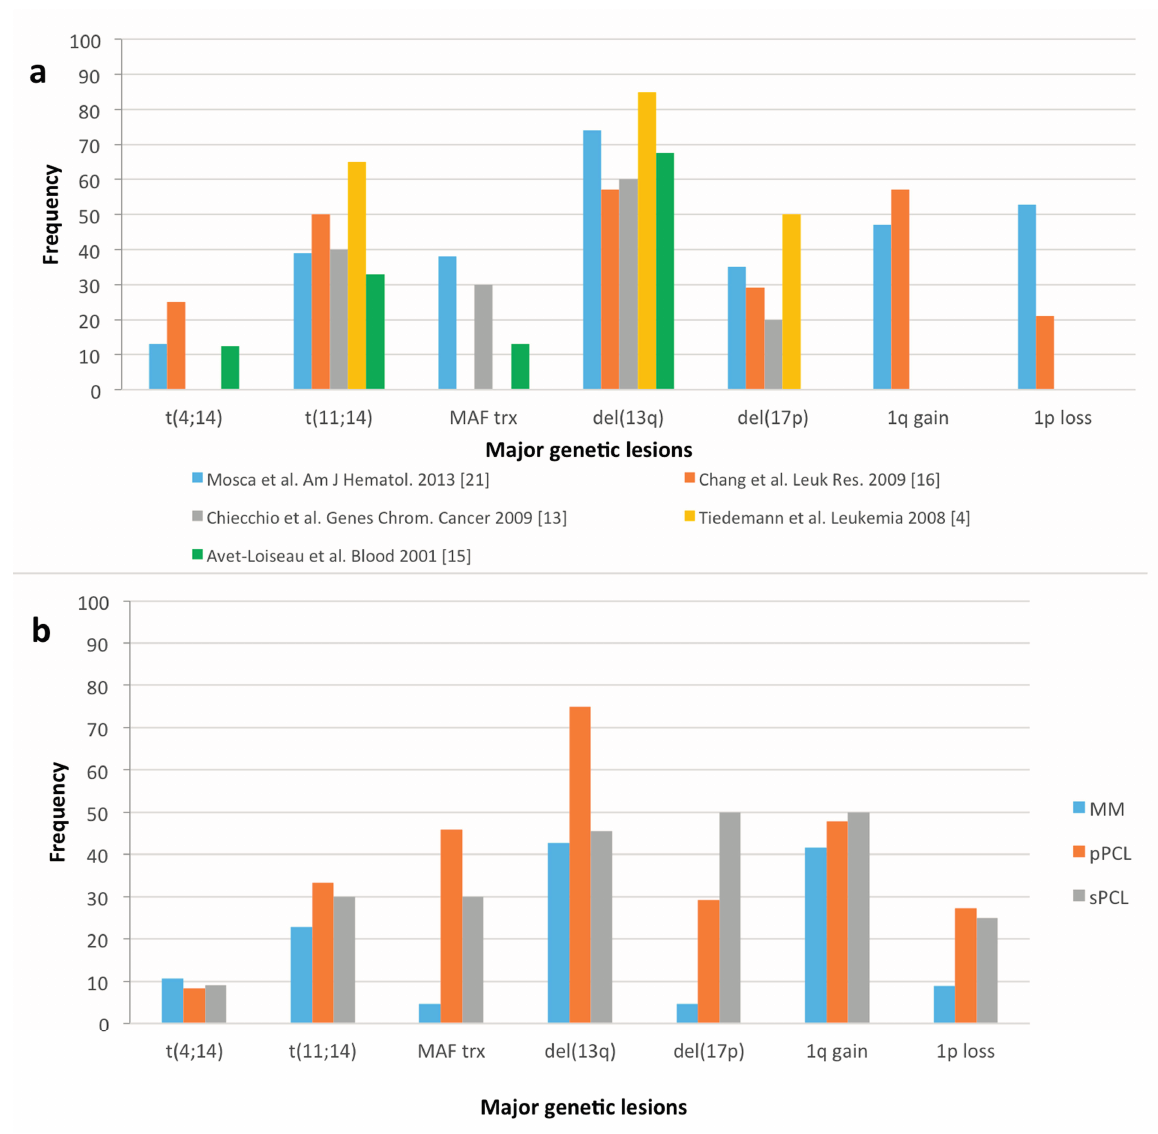
Figure 1. ( a ) Percentage of main genetic alterations in primary plasma cell leukemia (pPCL) patients of our prospective series compared to other retrospective pPCL cohorts; ( b ) Percentage of the same genetic lesions in the proprietary dataset of 132 multiple myeloma (MM) patients at onset, 24 pPCL and 11 secondary plasma cell leukemia (sPCL) cases (elaborated from Lionetti et al ., Oncotarget 2015 [22]). Main chromosomal translocations, involving the immunoglobulin heavy-chain locus (IgH@) at 14q32 as t(4;14), t(11;14), MAF-translocations (trx), chromosome 13 and 17 deletions (del(13q), del(17p)), and chromosome 1 gains and losses (1q gain, 1p loss) are